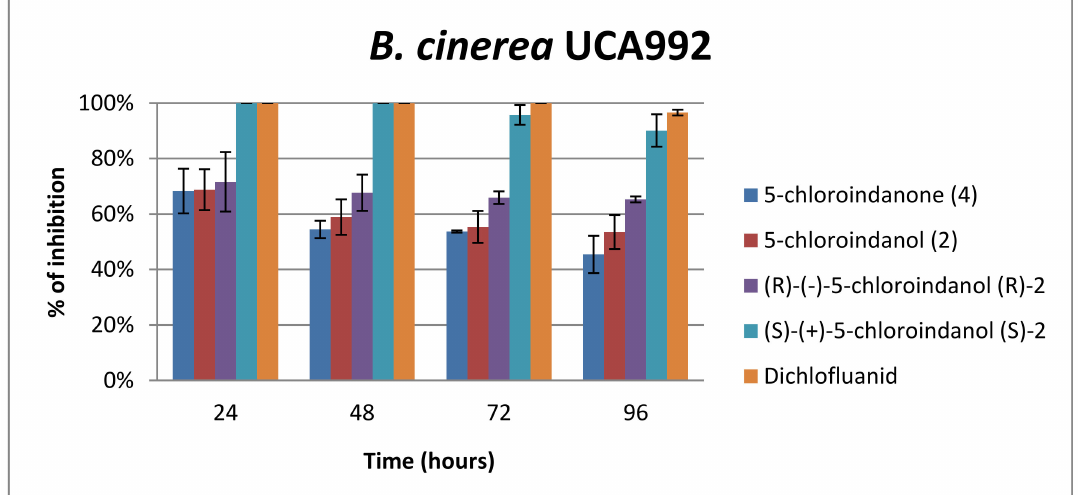
Figure 2. Results of antifungal bioassays for 5-chloroindanol ( 2 ) derivatives at 100 µ g /